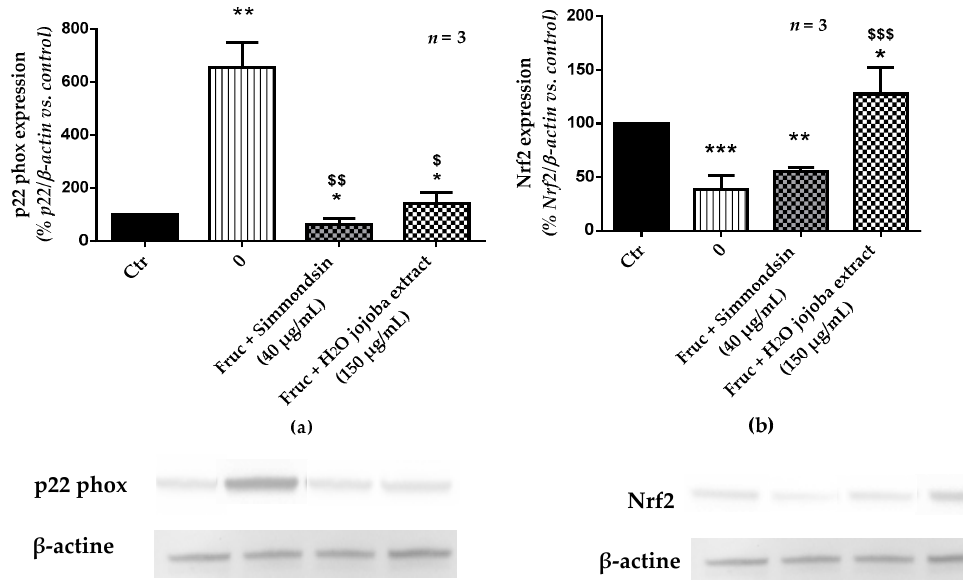
Figure 6. Effect of the aqueous jojoba seed extract and simmondsin on p22phox ( a ) and nuclear factor (erythroid-derived 2)-like 2 (Nrf2) expression ( b ). Each value represents the mean ± standard error of the mean (SEM) of three independent experiments in triplicate. * p < 0.05, ** p < 0.01, *** p < 0.001, compared to untreated cells, $ p < 0.05, $$ p < 0.01, $$$ p < 0.001, compared to fructose-treated cells.